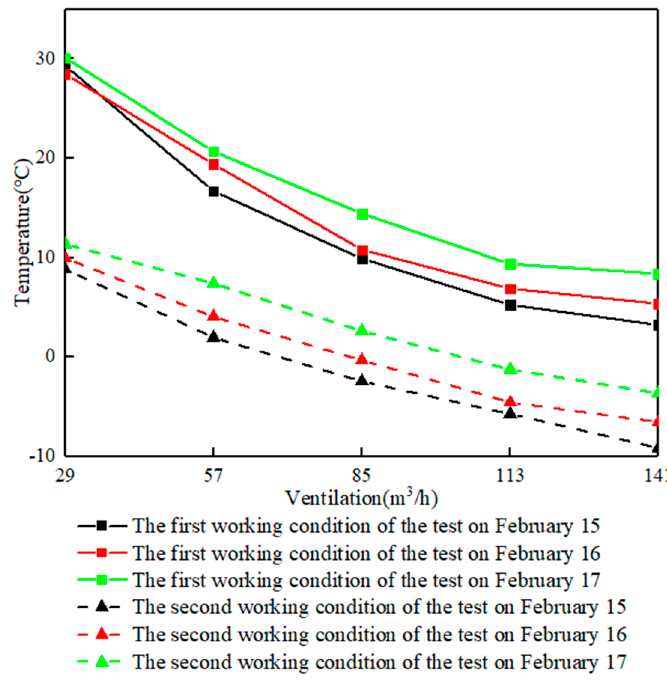
Figure 5. Fresh air preheating experiment results.